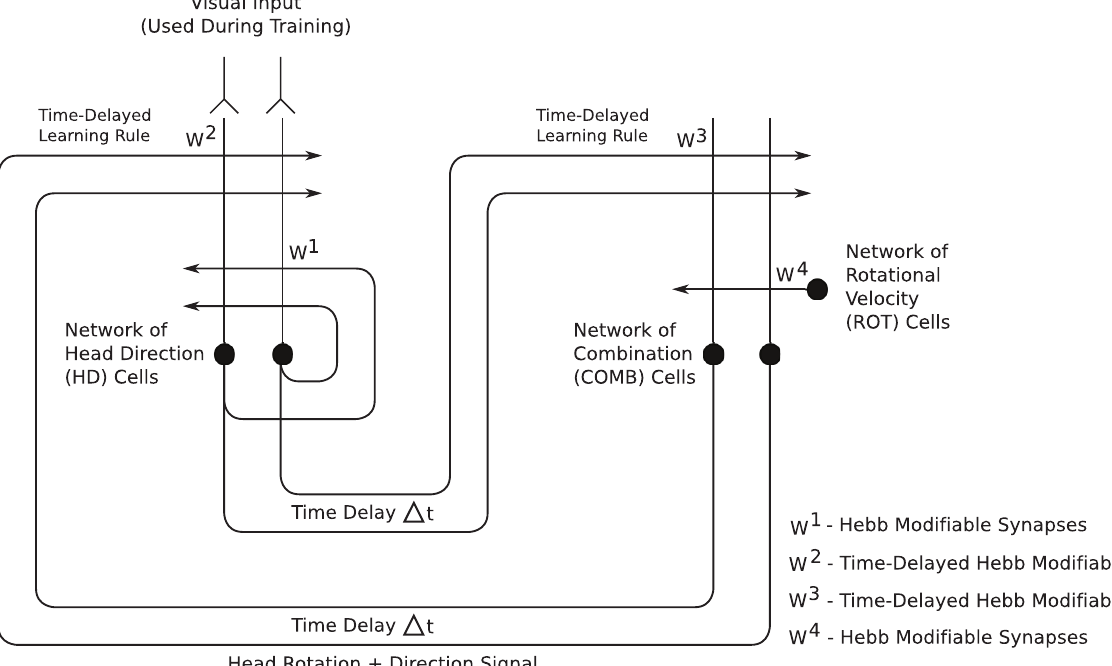
Figure 2. Architecture and operation of a simple two-cell model and its relationship to a larger many-cell model. a) In the simple two- cell model, a presynaptic cell 1 is connected to a postsynaptic cell 2. The propagation of signals from the presynaptic cell 1 to the postsynaptic cell 2 is subject to a transmission delay of duration D t . b) The simple two-cell model integrated into the full two-layer path integration neural network with reciprocal synaptic connections between the two layers. The left layer of neurons may be considered to correspond to a ring of head direction cells, while the right layer corresponds to a ring of combination cells that represent specific combinations of head direction and angular velocity. Propagation of signals from the head direction cell layer to the combination cell layer, e.g. from cell 1 to cell 2, is subject to a transmission delay of duration D t . Propagation of signals from the combination cell layer to the head direction cell layer, e.g. from cell 2 to cell 3, is also subject to a transmission delay of duration D t . c) The time course of the firing profiles of cells 1, 2 and 3 during path integration after training has taken place. Consider a three-cell synaptic pathway, cell 1 ? cell 2 ? cell 3. The transmission delay of D t in the propagation of signals from cell 1 to cell 2 ensures that if the centre of mass of the firing profile of cell 1 occurs at time t , then the centre of mass of the firing profile of cell 2 will occur at time t z D t . Similarly, the transmission delay D t in the propagation of signals from cell 2 to cell 3 ensures that the centre of mass of the firing profile of cell 3 will occur at time t z 2 D t